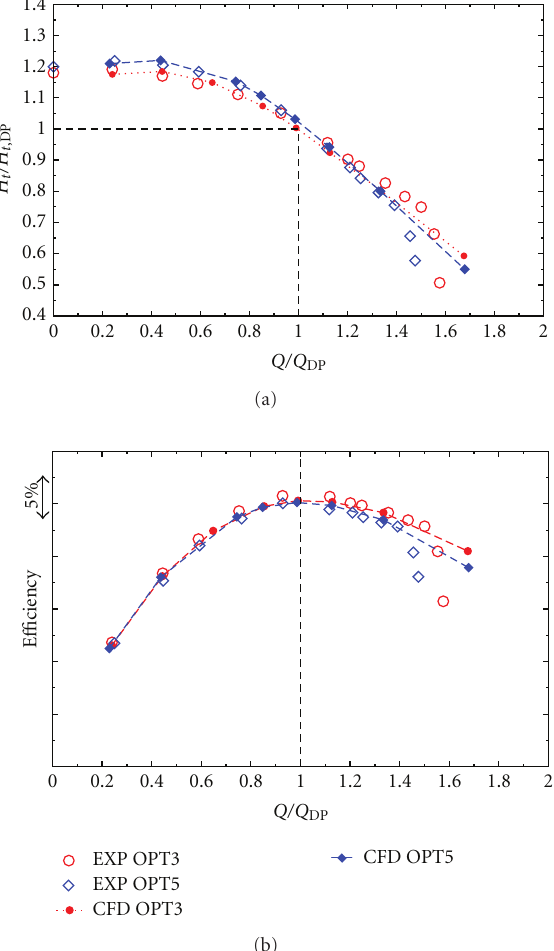
Figure 9: Comparison between computed 3-blade and 5-blade pump characteristics ( N s = 9 . 5).